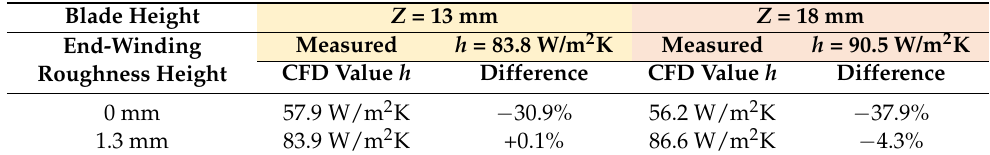
Table 6. Comparison of HTC values, obtained by CFD simulations, for different values of roughness height ( N = 12, n = 3000 min − 1